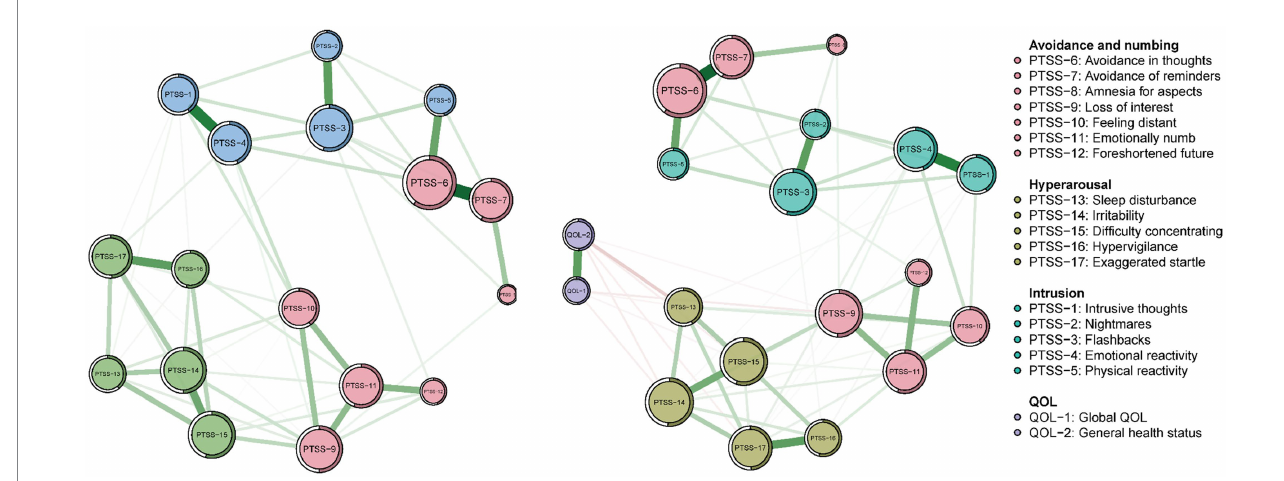
FIGURE 4 Network models in the whole sample ( N = 10,516) estimated by the Extended Bayesian Information Criterion (EBIC) method after adjusting for age and sex. Network model of PCL-C after adjusting for covariates ( left ) and network model of PCL-C and QOL after adjusting for covariates ( right ). The size of each node indicates the relative level of strength. Green edges indicate positive associations; red edges indicate negative associations. For easy comparison with network graphs without adjusting for covariates, the layouts of panels followed the layouts of the two network graphs without adjusting for covariates (Figure 1 and Supplementary Figure